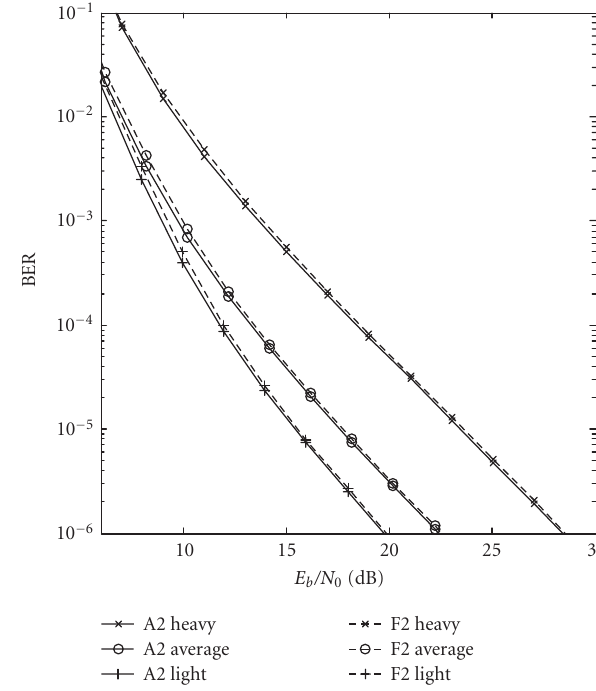
Figure 2: Upper bounds for codes A2 and F2 with single transmit antenna over shadowed Rician channels (1-TX and 1-RX antenna).